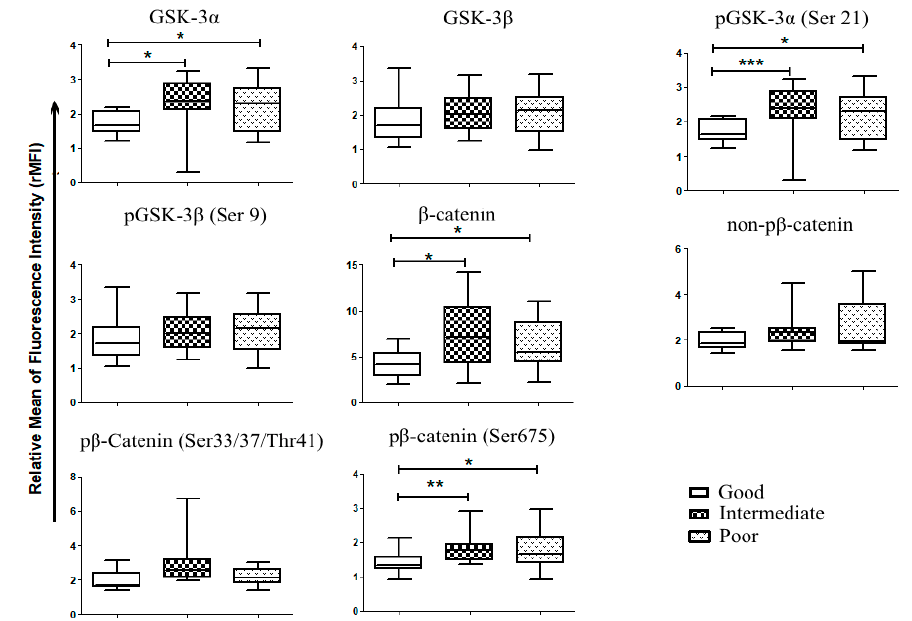
Figure 4. Wnt and GSK-3expression in primary AML samples according to patient stratification. Patient samples analyzed for Wnt expression, were stratified according to their mutational status and their cytogenetics into 3 risks group as proposed by the European Leukemic Network (ELN)s; favorable risk or good ( n = 11), intermediate ( n = 12) and poor ( n = 13). Mann–Whitney test was used to analyze differences between the two groups * p < 0.05, ** p < 0.01, *** p < 0.001.